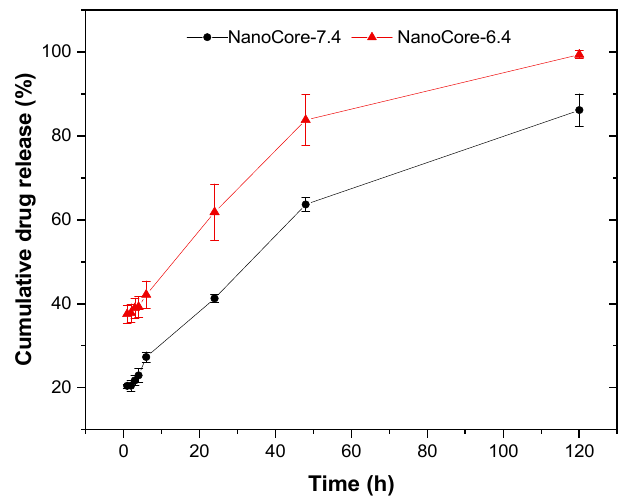
Figure 2. In vitro drug release of doxorubicin from NanoCore-6.4 (red) and NanoCore 7.4 (grey) in an aqueous poloxamer 188 solution (1%) determined by ultracentrifugation at a dilution of 1:25 ( n = 3, mean ± standard deviation).